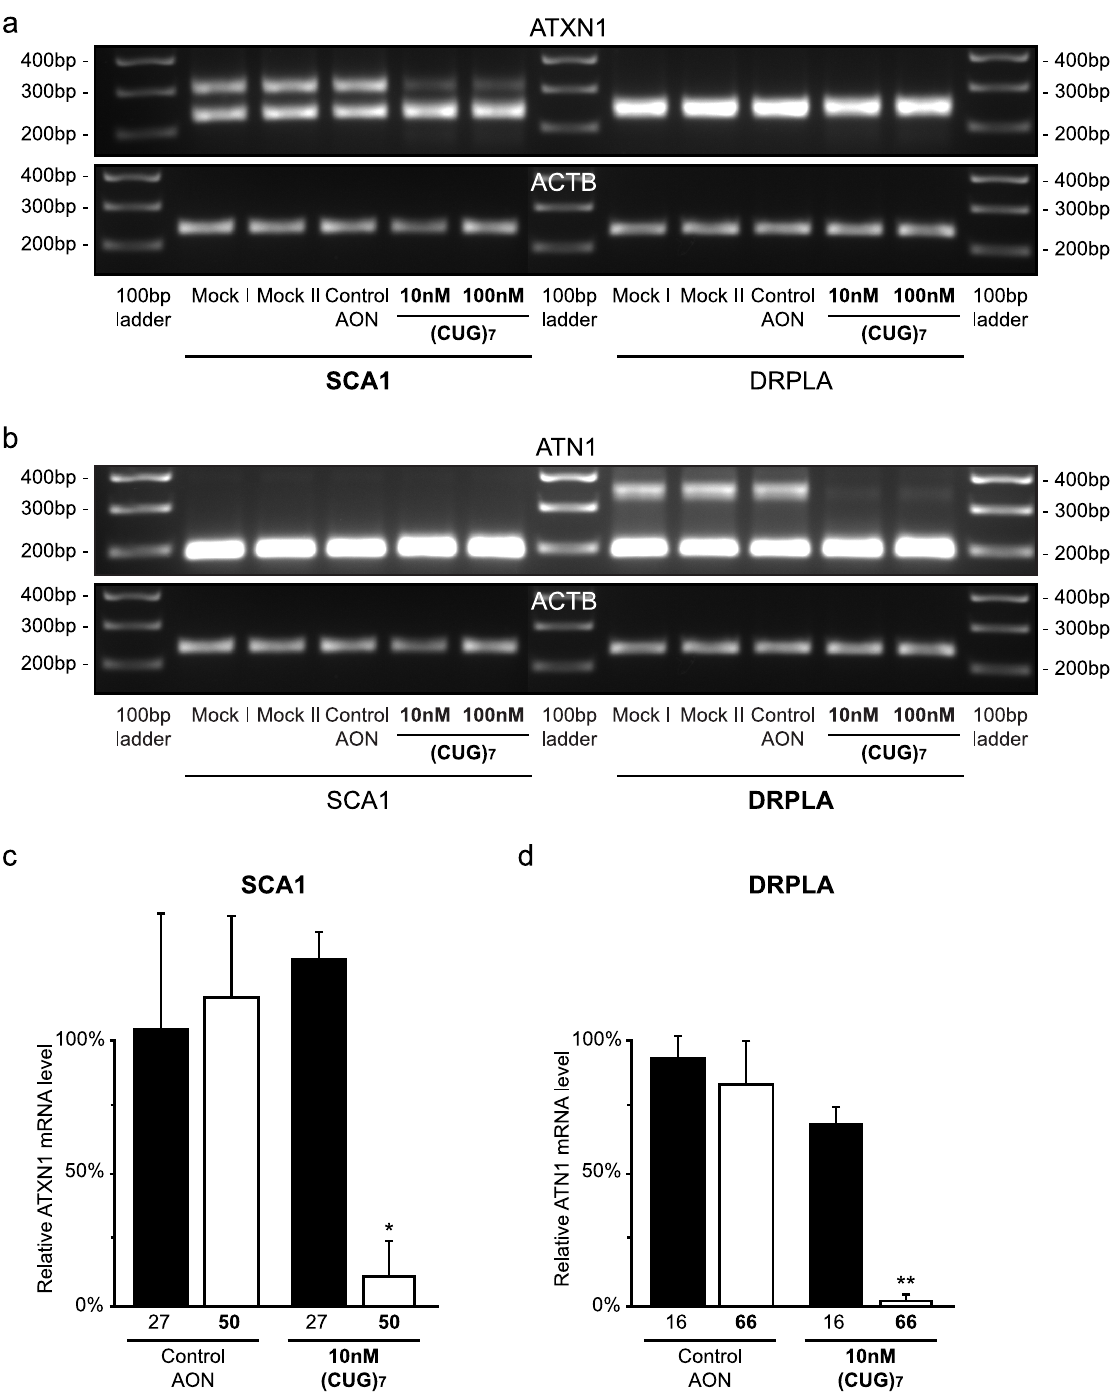
Figure 6. (CUG) 7 AON reduces mutant ATXN1 and ATN1 transcripts in SCA1 and DRPLA fibroblasts. SCA1 (GM06927) and DRPLA (GM13716) patient derived fibroblasts were transfected with 10 and 100 nM (CUG) 7 , 10 nM non-htt specific h40 AON2 (Control AON), transfection agent only (Mock II), or non-transfected cells (Mock I). (a) Agarose gel analysis with primers flanking the CAG repeat in the ATXN1 transcript. After transfection with both 10 nm and 100 nM (CUG) 7 the upper band, representing the mutant ATXN1 transcript, is greatly decreased in intensity, while the lower band, representing the wild-type transcript, is not reduced. b -actin was used as loading control. (b) Agarose gel analysis with primers flanking the CAG repeat in the ATN1 transcript. After transfection with both 10 nM and 100 nM (CUG) 7 , the upper band representing the mutant ATN1 transcript, is greatly decreased in intensity, while the lower band representing the wild-type transcript, is not reduced. b -actin was used as loading control. (c) Lab-on-a-Chip analysis of ATXN1 transcripts in SCA1 cells after control AON and 10 nM (CUG) 7 treatment. The mutant transcript, with 72 CAGs, is significantly reduced by 89% after (CUG) 7 treatment, compared to transfection controls. The normal ATXN1 transcript with 27 CAGs is not reduced. (d) ImageJ analysis of ATN1 transcripts in DRPLA cells after control AON and 10 nM (CUG) 7 treatment. The 66 CAGs containing mutant ATN1 transcript is significantly reduced by 98% after (CUG) 7 treatment, while normal ATN1 transcript with 16 CAGs is not significantly reduced by 30%. Expression levels are corrected for loading differences with b -actin. The mRNA level of the Mock I transfection was set on 100% (* P , 0.05, ** P , 0.01, n=3).